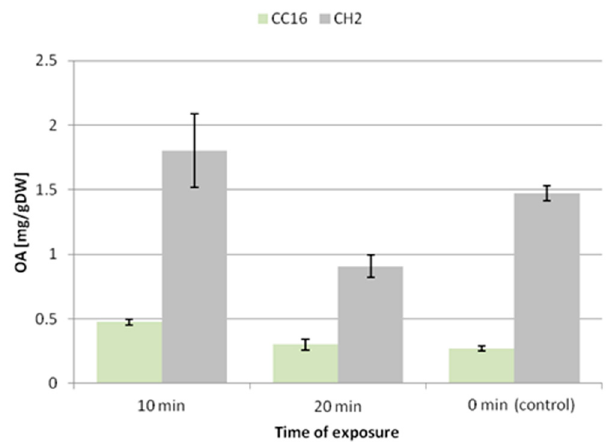
Figure 6. The content of oleanolic acid in hairy root tissue after elicitation with ultrasound. OA—oleanolic acid.